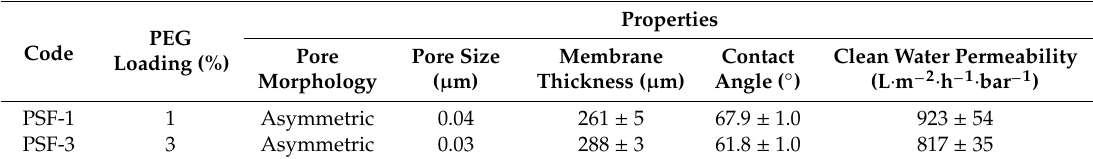
Table 1. Summary of the membrane